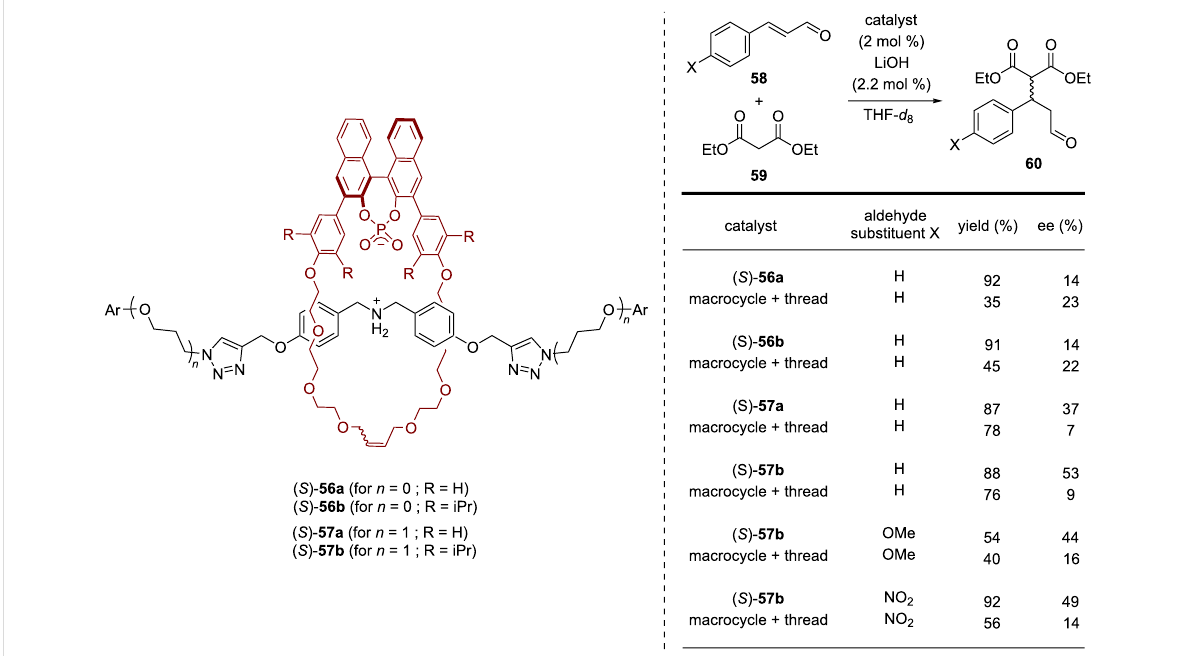
Figure 15: Results for the enantioselective Michael addition with different rotaxane catalysts ( S )- 56a / 56b / 57a / 57b and their non-interlocked counter- parts.